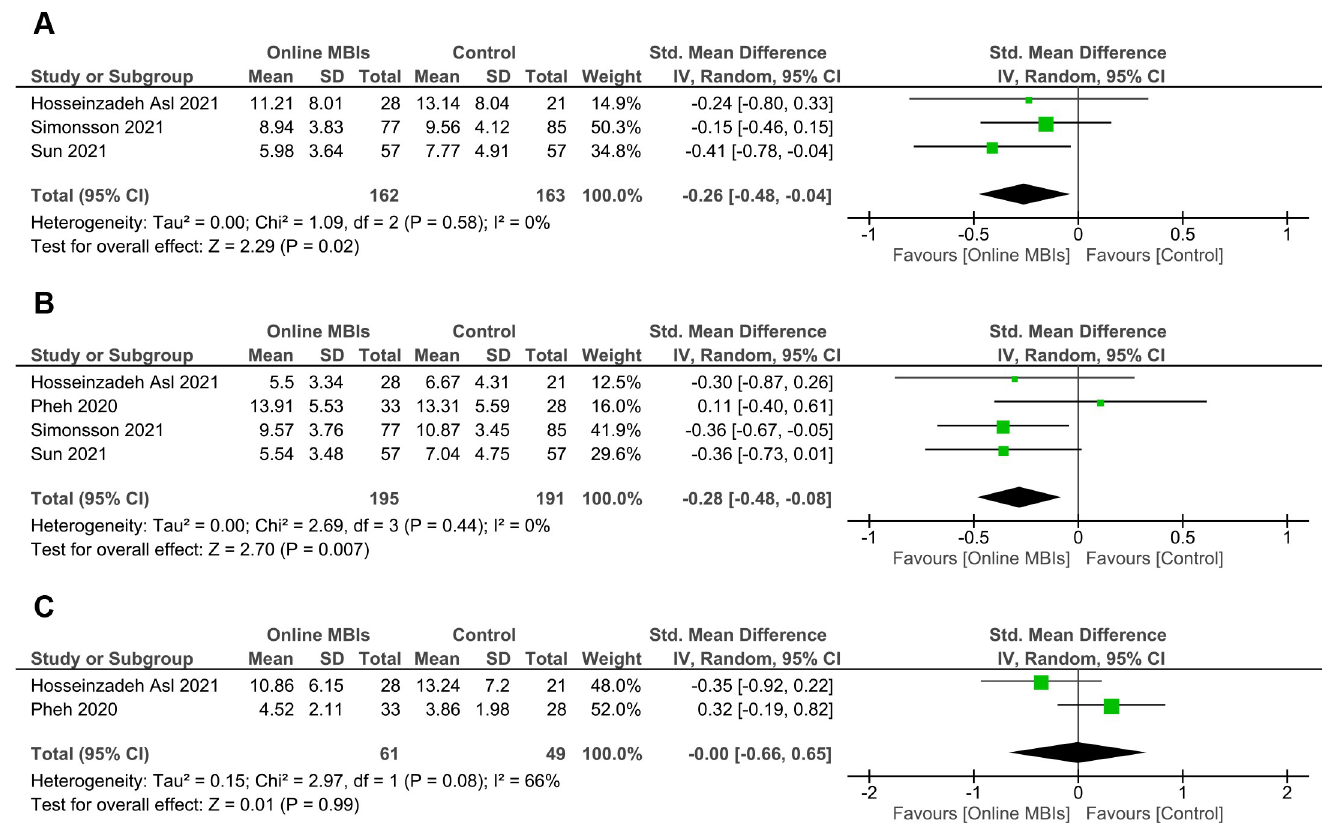
Fig 5. Forest plots of meta-analyses of online MBIs effect on mental health outcomes at follow-up. ( A ) Depression. ( B ) Anxiety. ( C ) Stress.